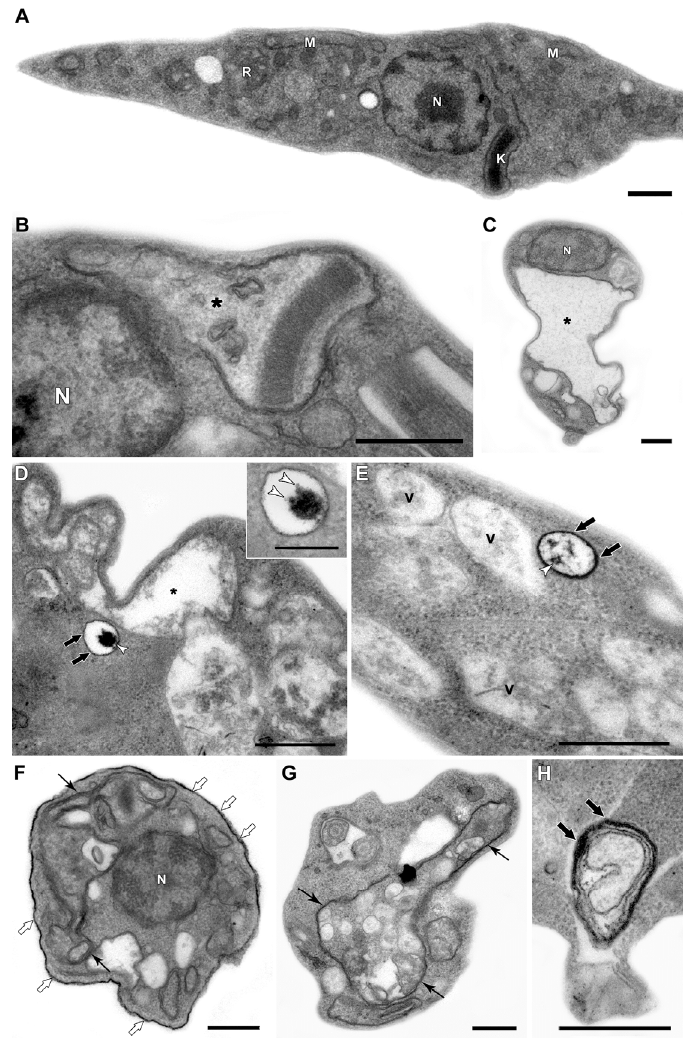
Figure 3. Ultrastructural effects of CdTe QDs on T. cruzi epimastigotes. ( A ) Untreated epimastigote showing normal morphological characteristics; ( B – H ) Parasites incubated with 200 µM QDs presented mitochondrial swelling (black asterisks) and the cytosolic vesicles containing QDs (thick black arrows). Aggregates of QDs inside the structure were observed (white arrowheads). The incubation of QDs also induced intense vacuolization in the cytosol (V) and the appearance of endoplasmic reticulum profiles (black arrows) surrounding organelles and other cytosolic degraded structures. QDs were also detected on the epimastigote surface (thick white arrows). Nucleus (N), mitochondrion (M), kinetoplast (K) and reservosome (R). Bars: A–H: 0.5 µm; inset in D: 0.2